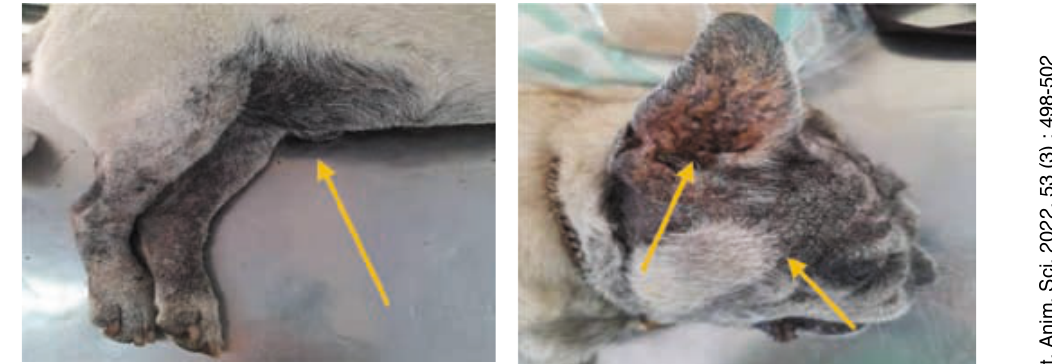
Fig. 1. and 2 Lesions of malassezia otitis and dermatitis